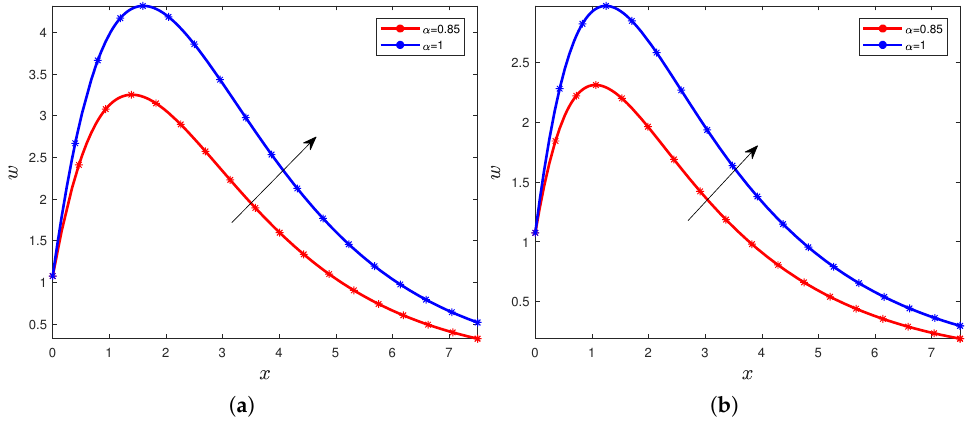
Figure 13. Velocity with the order α = 0.85 and α = 1 with Pr = 5 ( a ) Pr = 10 ( b ).